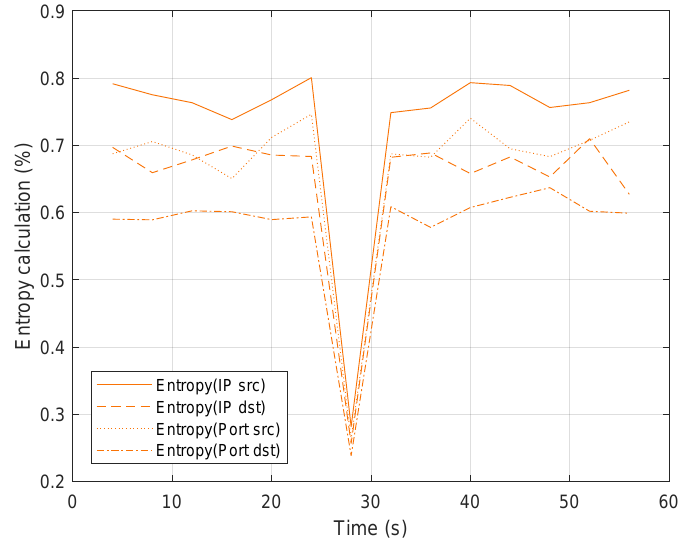
Figure 4. Entropy values during the Denial of Service (DoS)